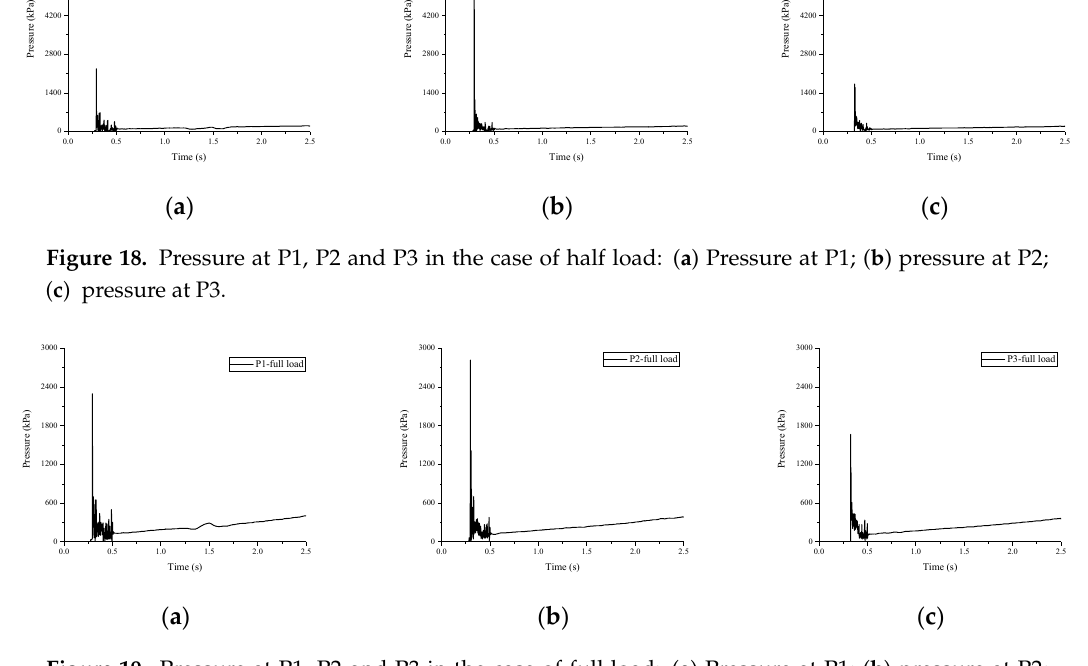
Figure 19. Pressure at P1, P2 and P3 in the case of full load: ( a ) Pressure at P1; ( b ) pressure at P2; ( c ) pressure at P3.